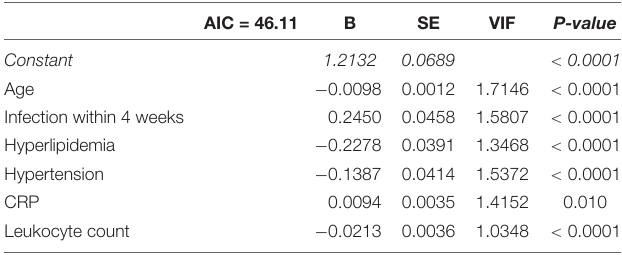
TABLE 3 | Logistic regression analysis for the presence of myocarditis using the 6 predictors identified by LASSO regression. AIC = 46.11